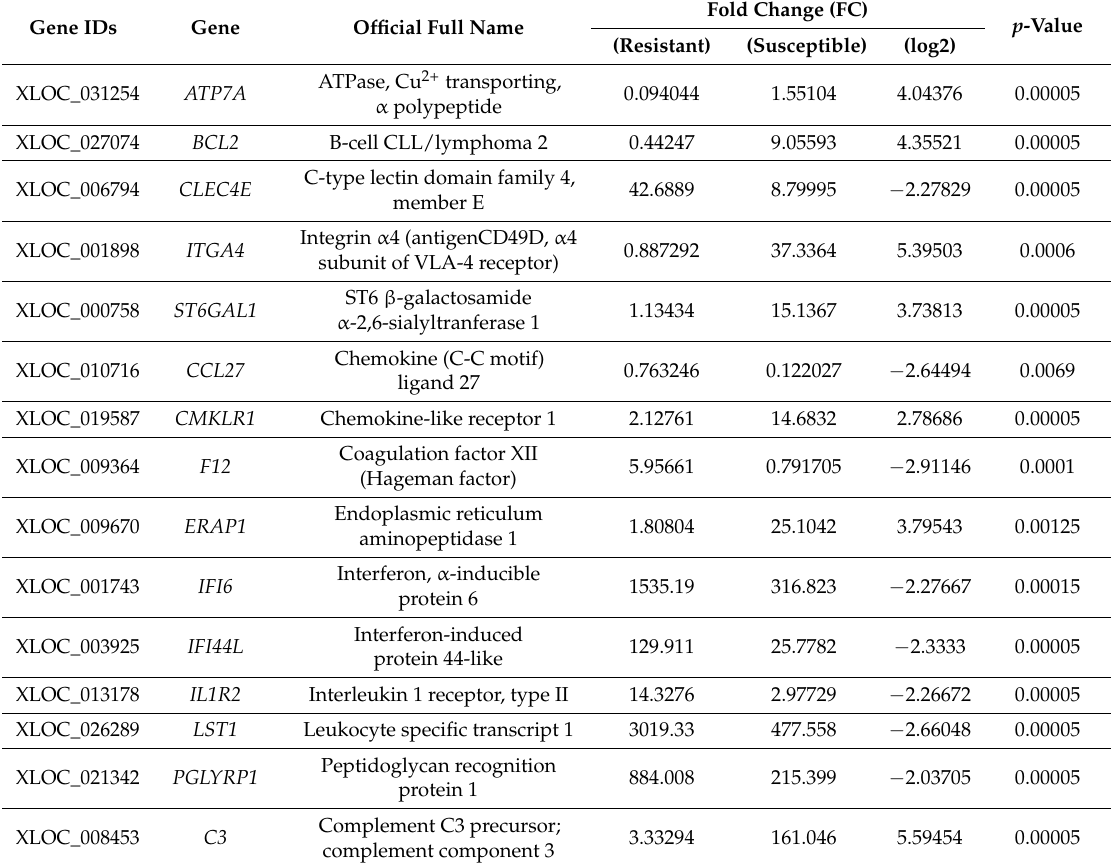
Table 5. DEGs that are regulated in the immune response of resistant and susceptible